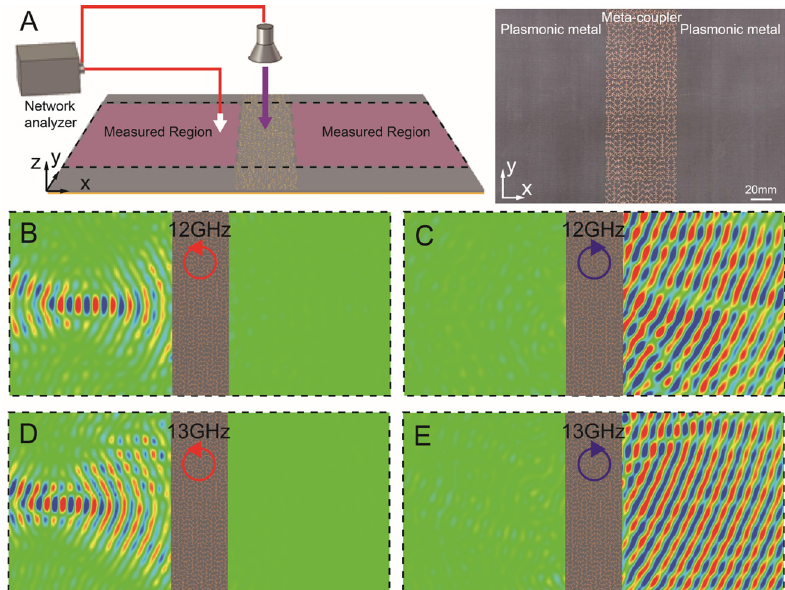
Figure 4: Experimental demonstration on helicity-delinked SW